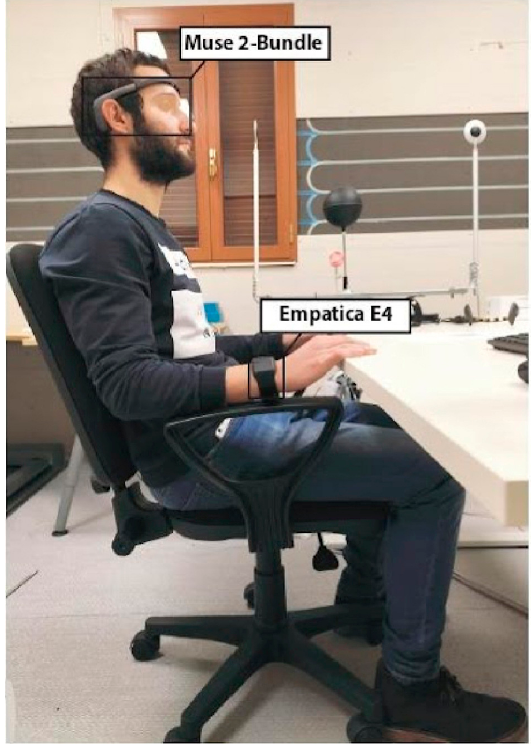
Figure 4. The subject wearing wearable devices: Muse 2-Bundle and Empatica E4 [79].